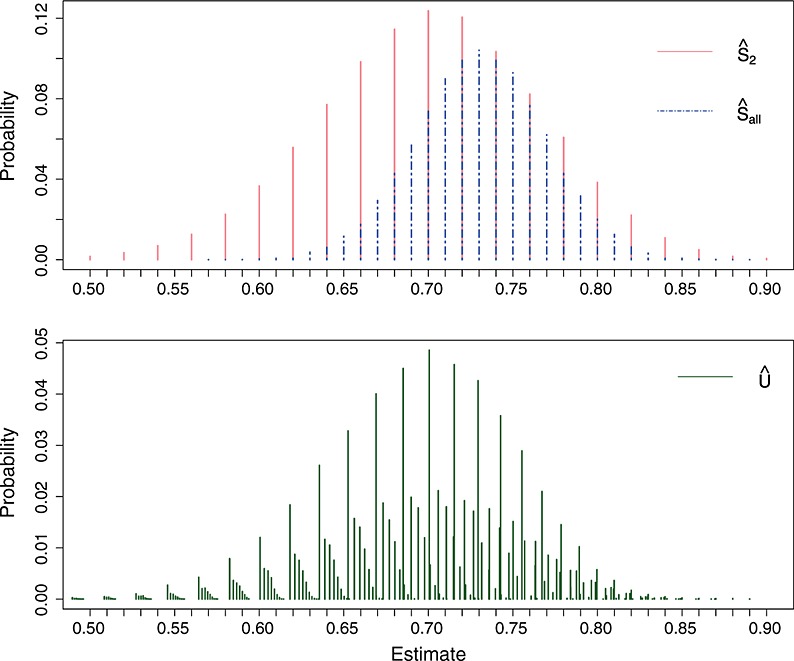
Probability mass functions of the estimators for S = (0.70,0.70,0.70), n1 = (50,50,50), c = 0.70n1 = (35,35,35) and n2=50. Each mass function is based on 100,000 simulations.